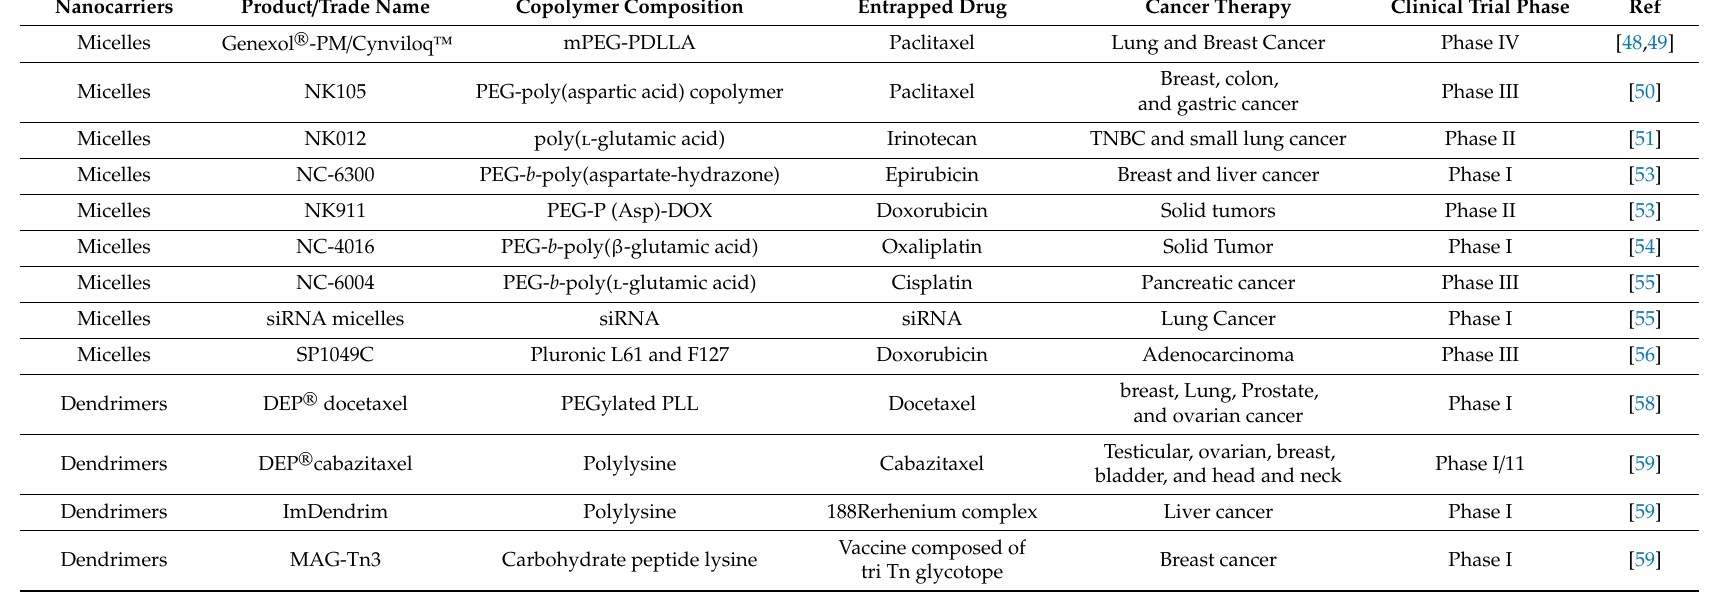
Table 2. Clinical status of polymeric micelles and dendrimers